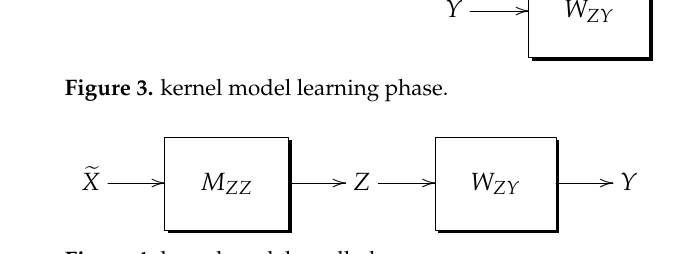
Figure 4. kernel model recall phase.